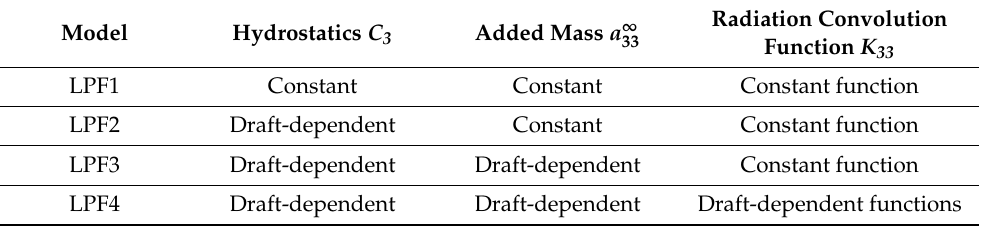
Table A3. Overview of the LPF1–4